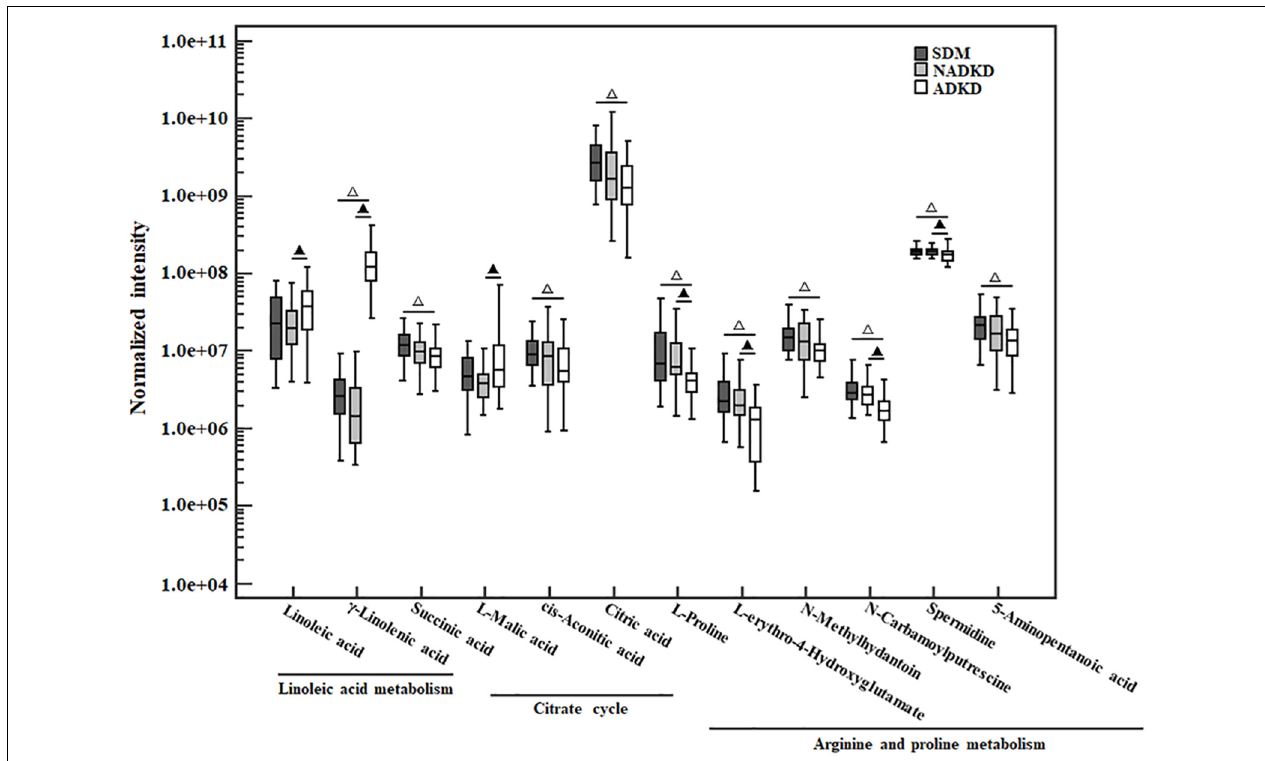
FIGURE 5 | The box plot of normalized intensity peak areas of differential metabolites. Compared with the SDM group, (cid:77) P < 0.05. Compared with the NADKD group, (cid:78) P <